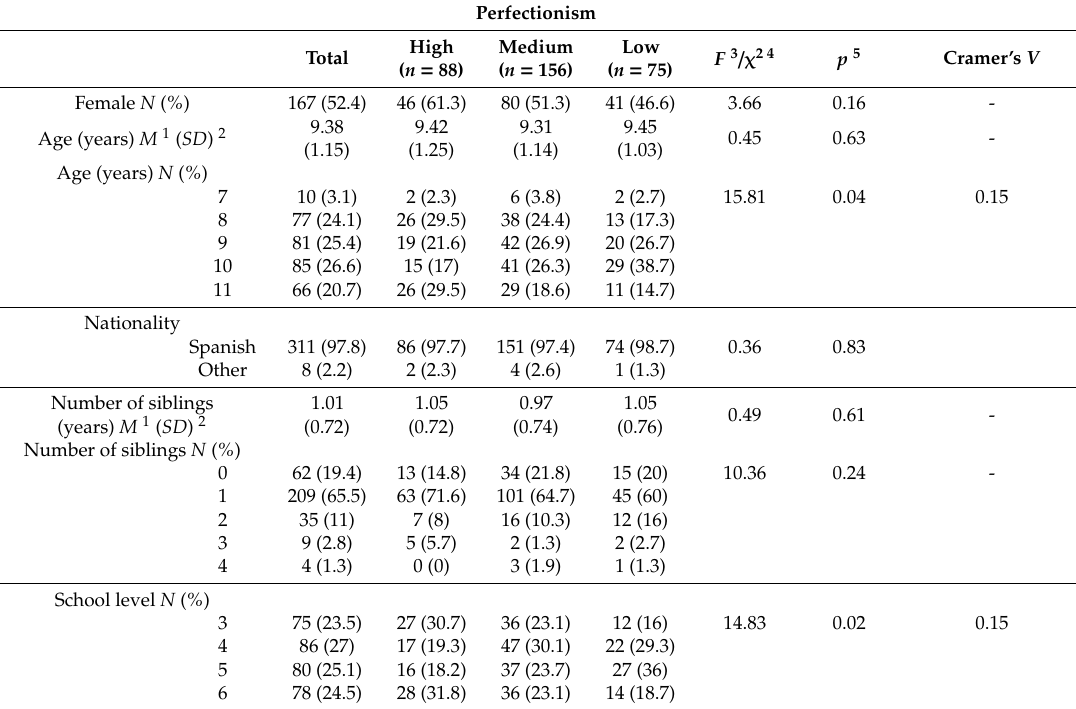
Table 1. Demographic description of the